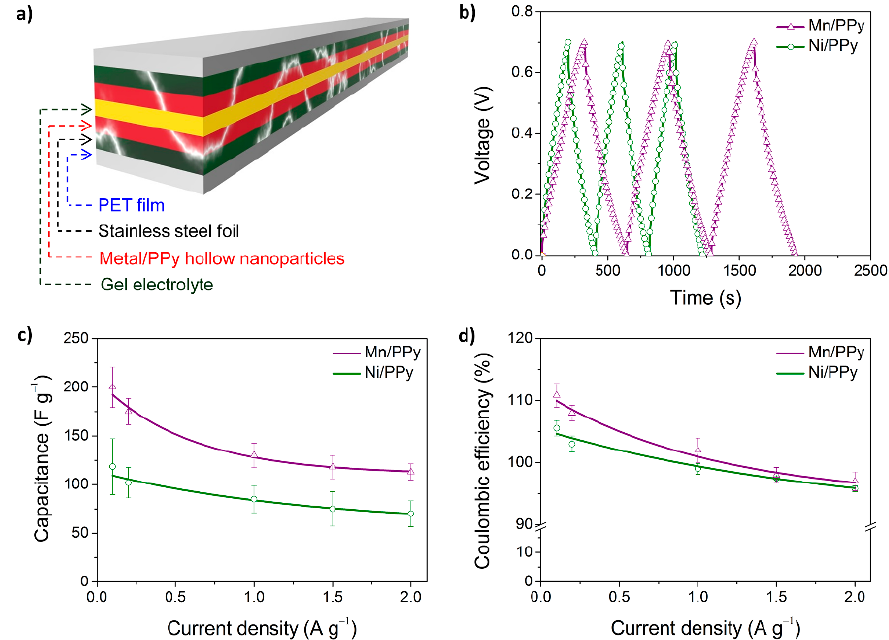
Figure 13. Flexible, all-solid-state cells based on Mn/PPy hollow nanoparticle electrodes. ( a ) Pictorial representation of an all-solid-state flexible electrochemical capacitor cell; ( b ) typical galvanostatic charge/discharge curves of metal/PPy hollow nanoparticles measured at a current density of 0.1 A·g − 1 ; ( c ) specific capacitances measured at different current densities; and ( d ) calculated coulombic efficiencies. Reprinted with permission from [67]. Copyright 2015, Nature Publishing Group.